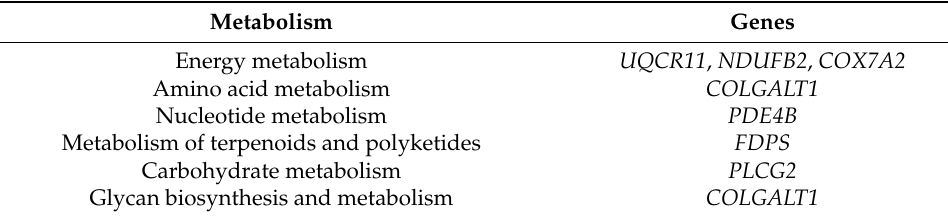
Table 2. DEGs involved in regulation of substance metabolism in the lower endothelial